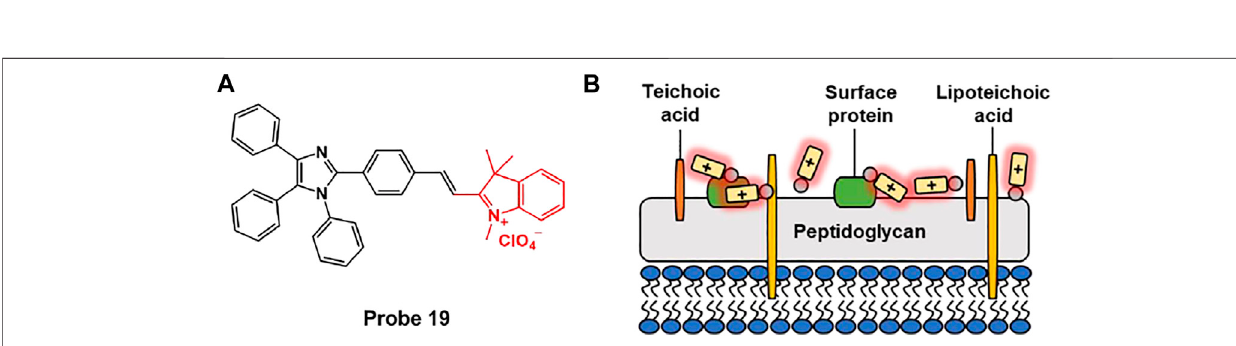
fl uorophore ( Figure 10C ) (Zhang et al., 2020a). To NTR in the presence NADH, the nitro group of the p -nitrobenzyl moiety was